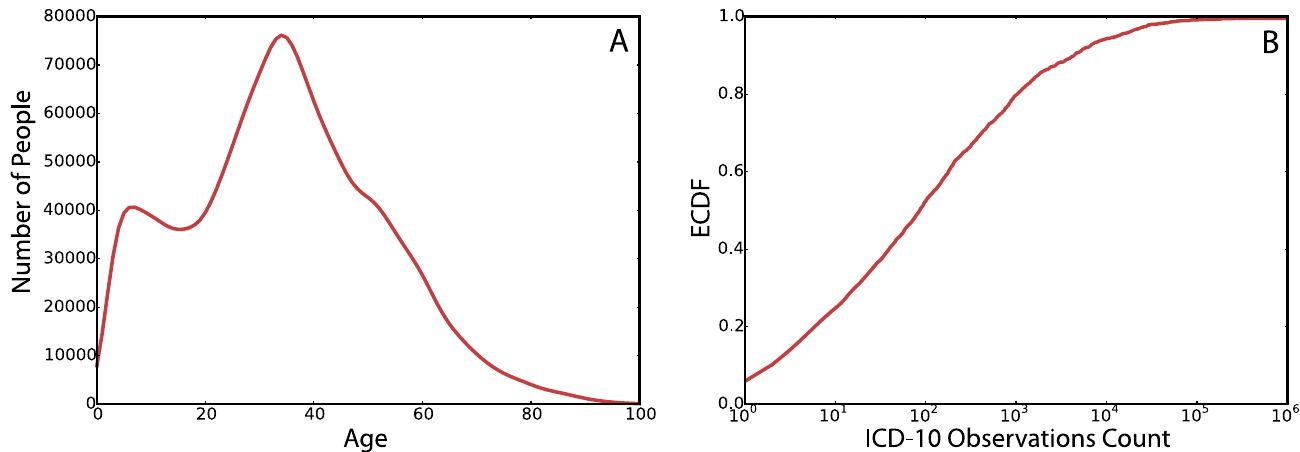
Fig 1. (A) The distribution of age in patients. (B) The cumulative density function of the ICD-10 codes by the number of observations in the data.